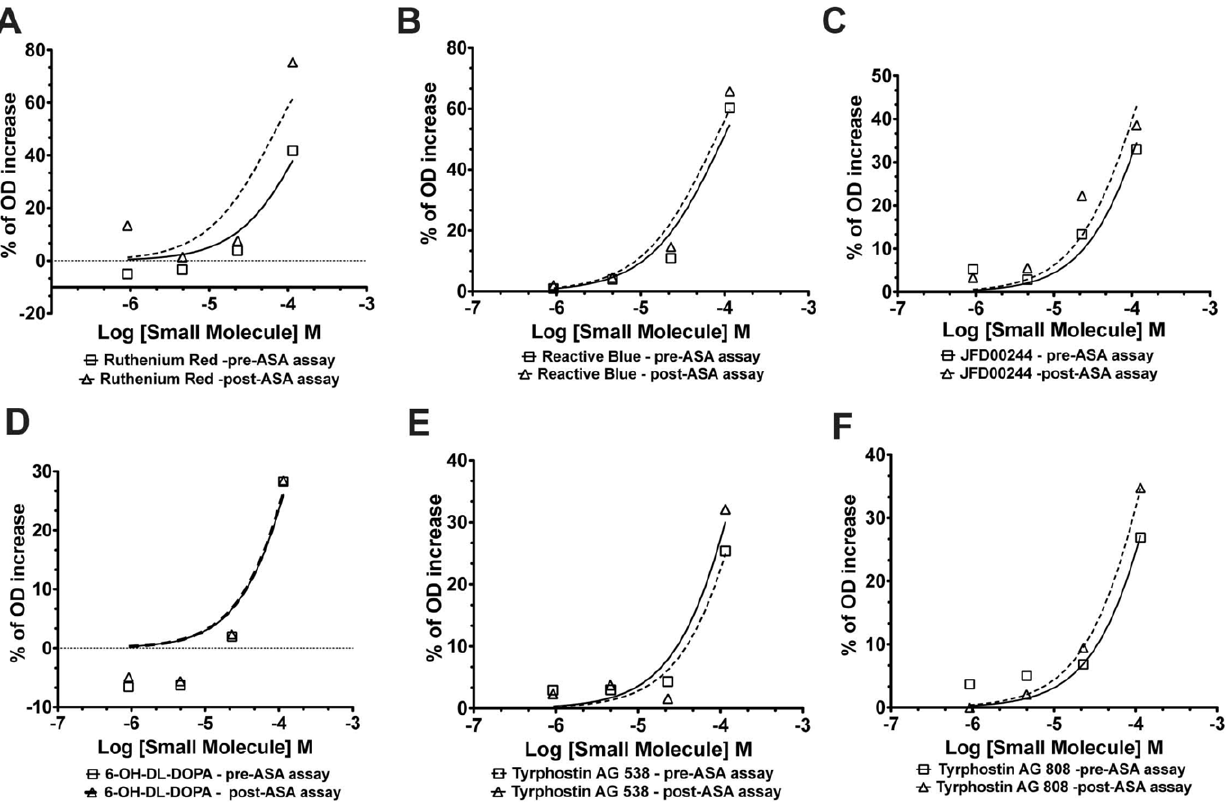
Figure 8. Concentration-response curve analysis of HTS assay for ASA to identify fluorescence and colorimetric compounds. In a 1,536-well plate with the SV40t cultured cells were positioned in the same format as previous assays. LOPAC library was dispensed prior to add substrate/lysis buffer for ASA and after terminating the assay with stop reaction solution. Six compounds depicted in these panels showed increases of the percentage of OD signal (relative to baseline mean of OD value from MLD patient cells). Four highest concentration of LOPAC (0.92, 4.5, 22.8 and 114.2 microM) were used are shown in log scale (in M). Full lines and squares points represent results from the assay in which LOPAC was added just prior to starting ASA assay reaction (pre-ASA assay). Dotted lines and open triangles showed results from the assay in which LOPAC was added after stopping ASA assay reaction (post-ASA assay).